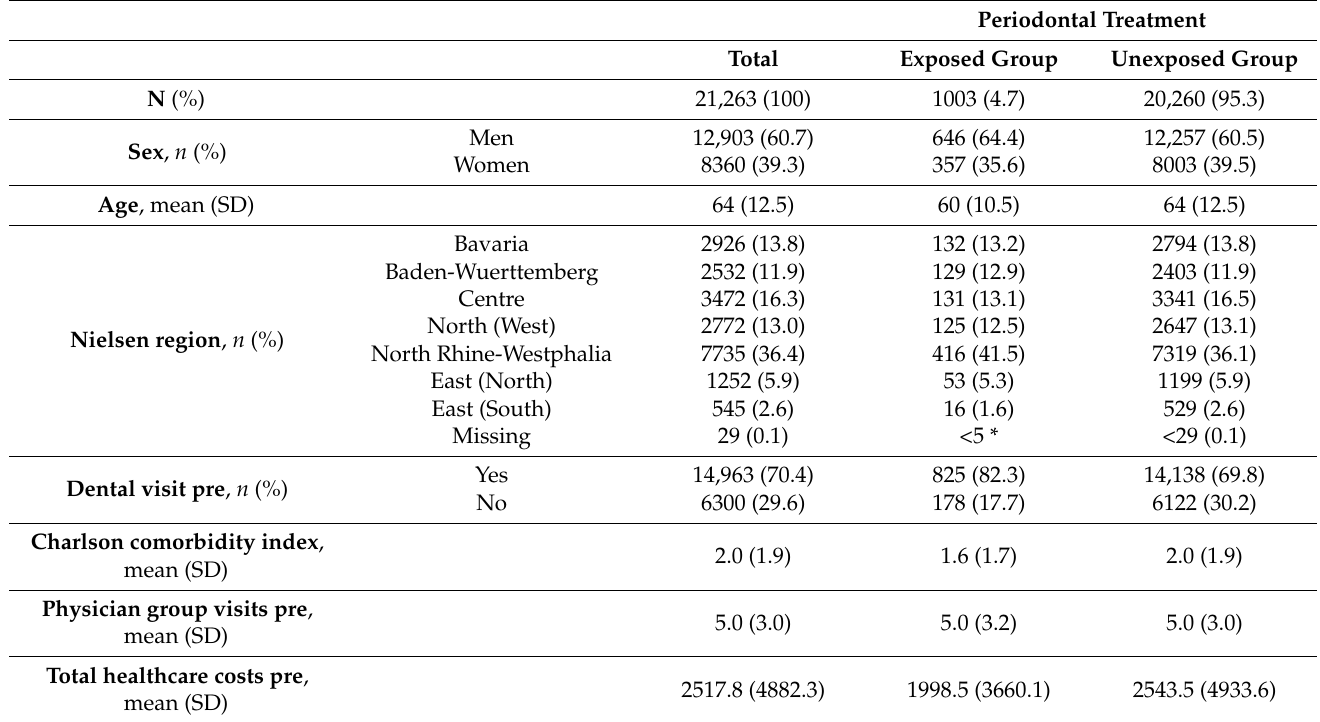
Table 1. Baseline characteristics of the study population, in total and differentiated by those exposed and unexposed to periodontal treatment.